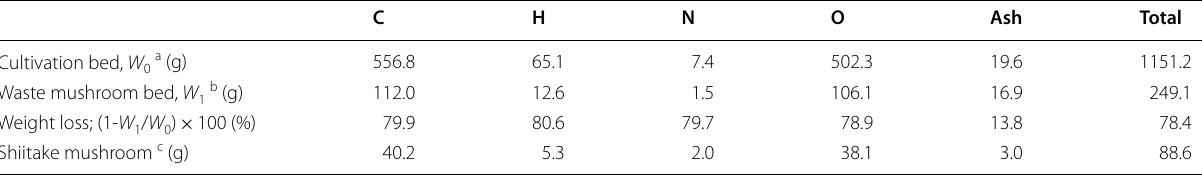
a , b Element weight of cultivation bed and waste mushroom bed, respectively c Sum of six repeated harvests from one cultivation bed